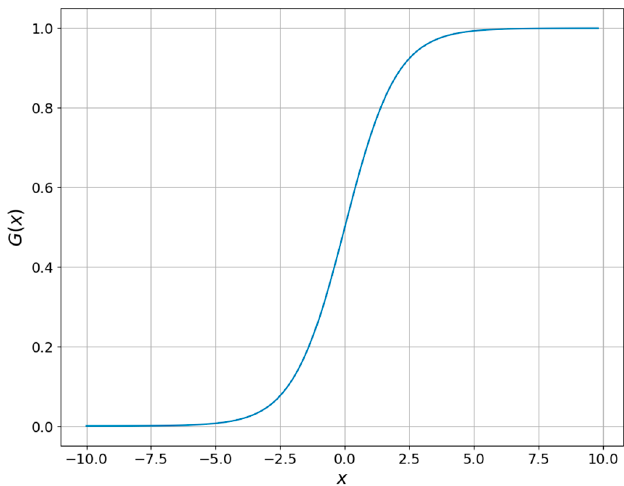
Figure 12. Sigmoid activation function.